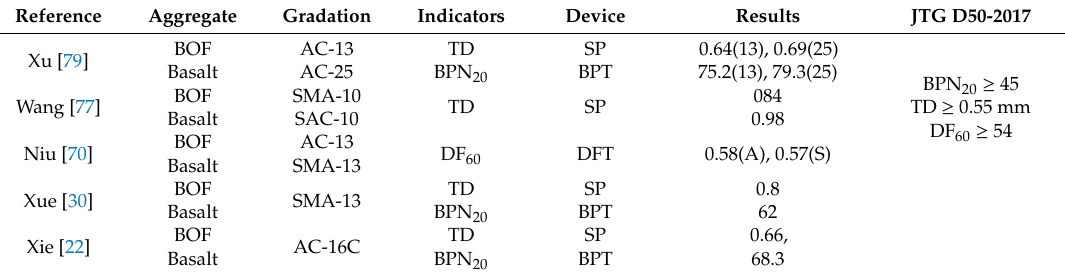
Table 8. Skid resistance of BOF slag asphalt mixtures with di ff erent